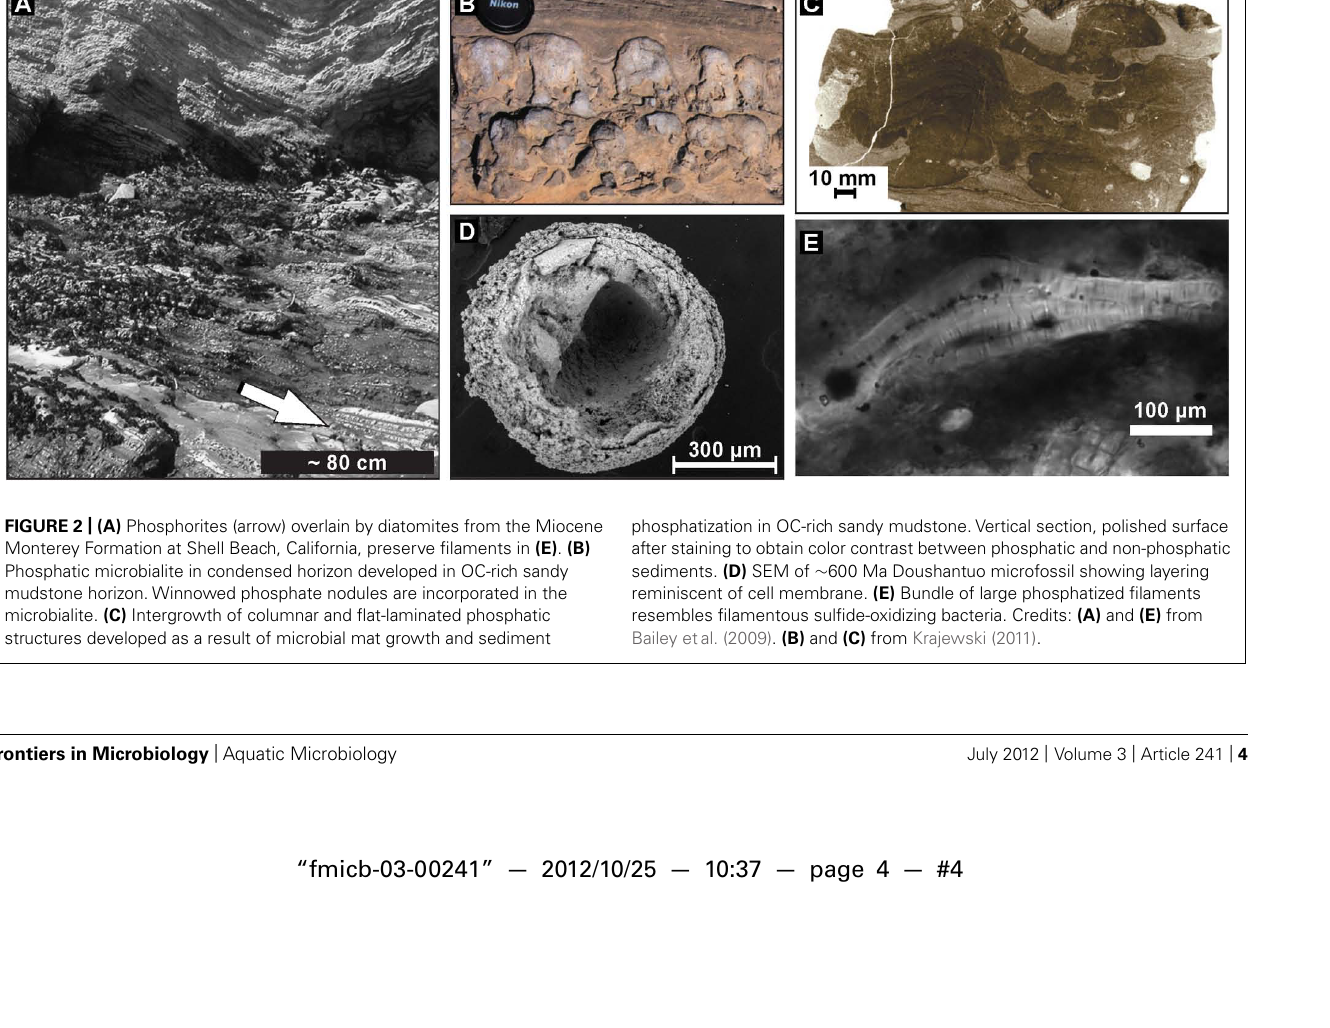
phosphatization in OC-rich sandy mudstone.Vertical section, polished surface after staining to obtain color contrast between phosphatic and non-phosphatic sediments. (D) SEM of ∼ 600 Ma Doushantuo microfossil showing layering reminiscent of cell membrane. (E) Bundle of large phosphatized filaments resembles filamentous sulfide-oxidizing bacteria. Credits: (A) and (E) from Bailey etal. (2009). (B) and (C) from Krajewski